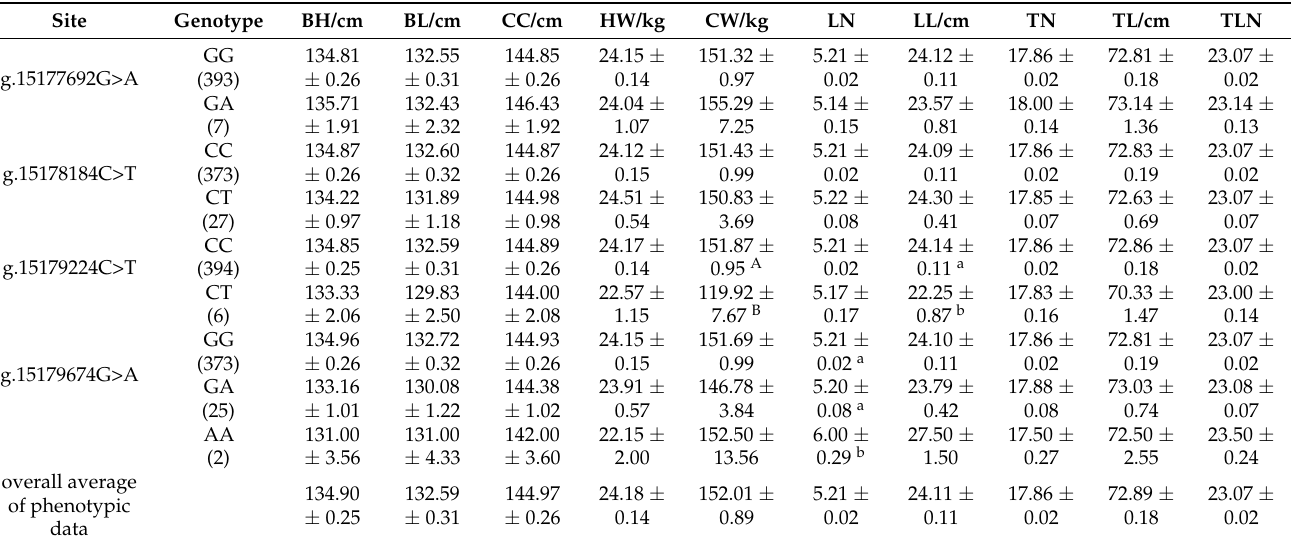
Table 4. LSMs with standard errors of each phenotype for different genotypes of 4 SNPs in Dezhou donkeys.